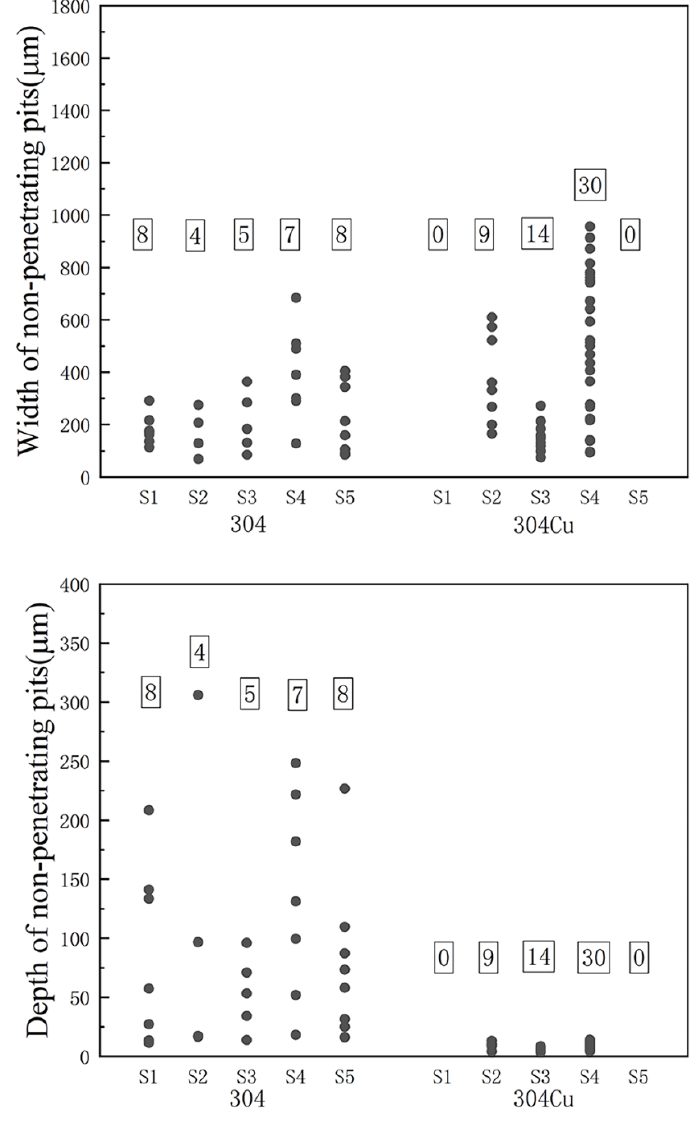
Figure 6. Non-penetrating pit depth and width of 304 and 304Cu after immersion in 6 wt.% FeCl 3 for 72 h.